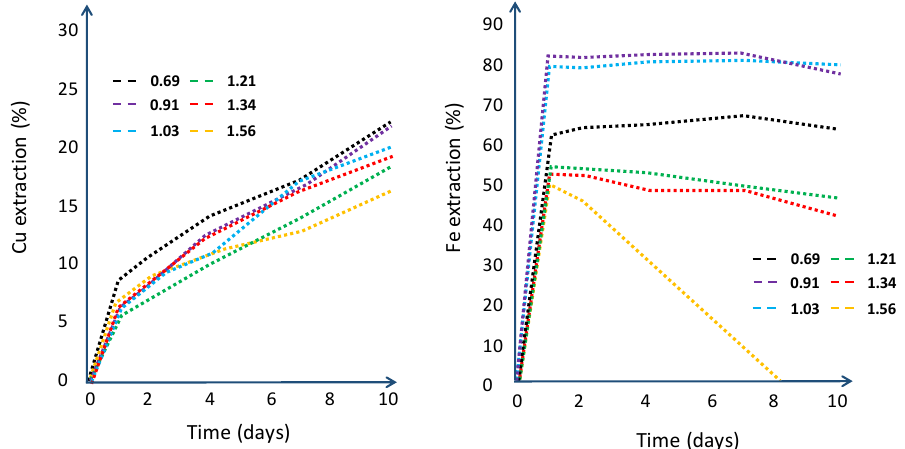
Figure 9. Copper and iron extraction in 25 g/L [Fe 3+ /Fe 2+ ], 10 g/L [Al 3+ ], 1 g/L [Mg 2+ ], 0.2 g/L [Cu 2+ ], 125 g/L [SO 42 − ], pH of 1.2, Eh of 700 mV, and temperature of 50 °C at different pH (Modified from [10]).